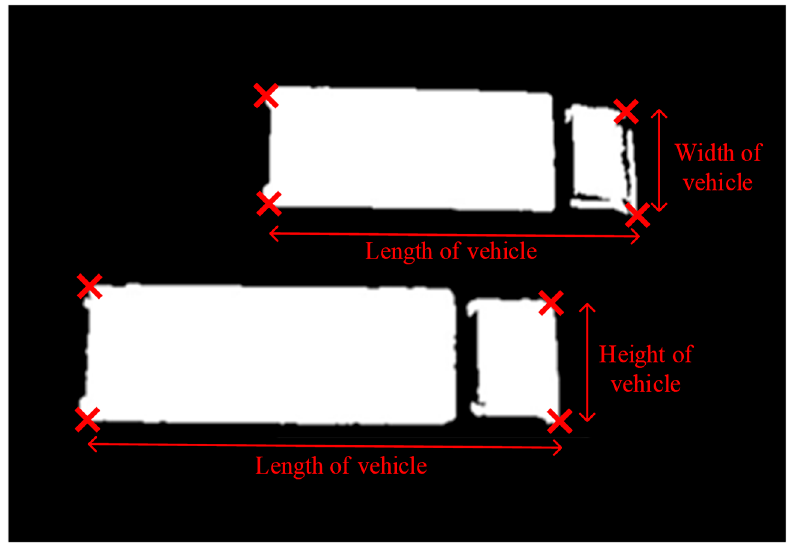
Figure 13. An illustration of geometric matching by the CVROSS.